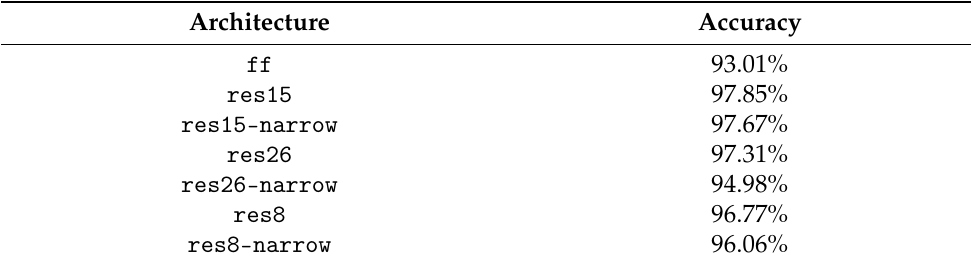
Table 13. Test accuracy on both Lithuanian and English commands after using Google Speech Commands dataset [38] as additional target samples.